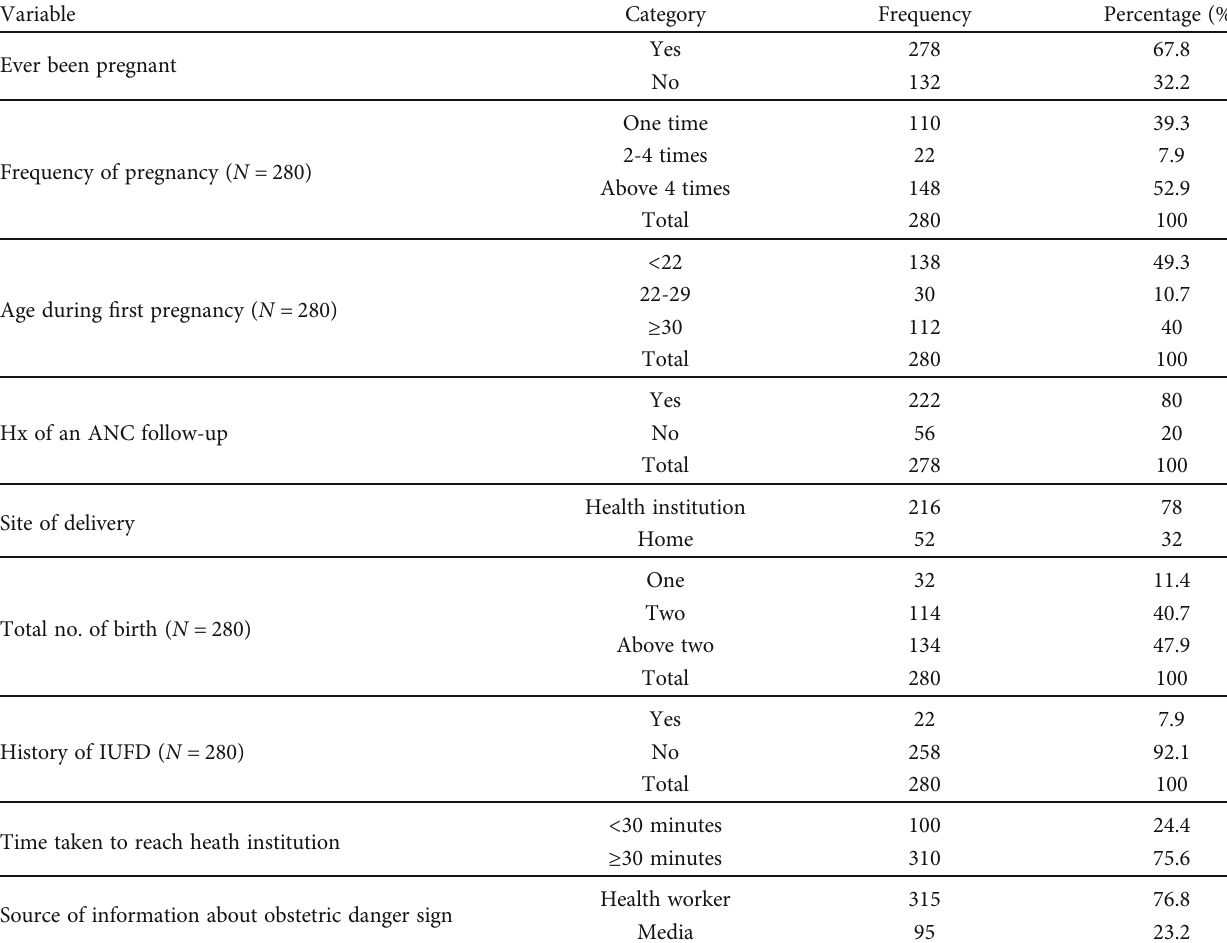
Table 2: Past obstetric characteristics of mothers aged 15 – 49 years in southeastern zone, Tigray Region, Northwest Ethiopia, 2021.